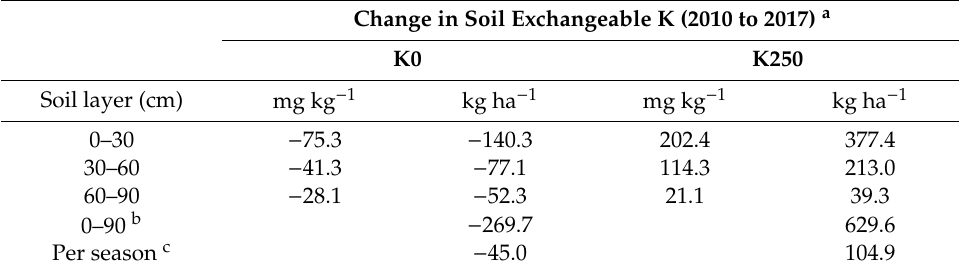
Table 6. Changes in soil exchangeable K as a function of K fertilization.